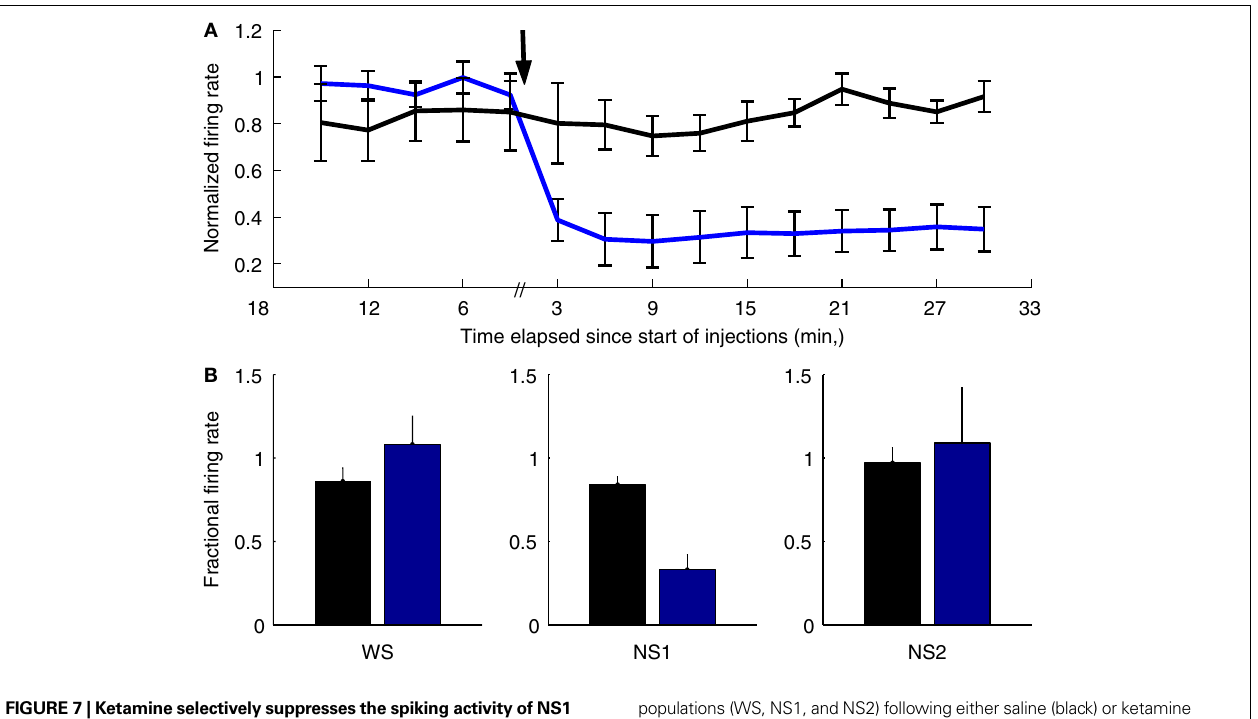
populations (WS, NS1, and NS2) following either saline (black) or ketamine (blue) administration. Bar graphs refl ect mean ± SEM fractional fi ring rate change calculated by dividing, for each cell, mean fi ring rate 2–17 min post-injection by the cell’s mean fi ring rate during the last 15 min of the baseline